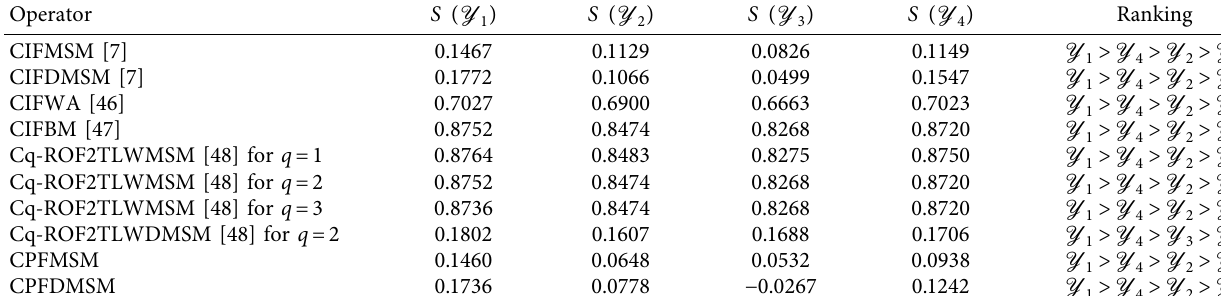
Table 12: Comparative analysis with previous existing